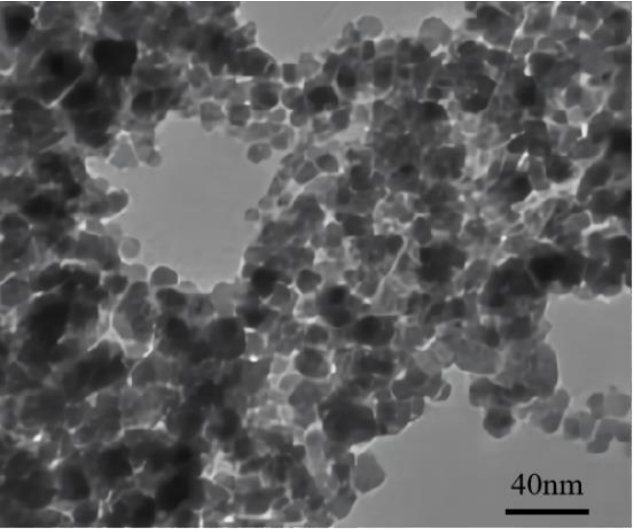
Figure 1. TEM images of the prepared Fe 3 O 4 particles.